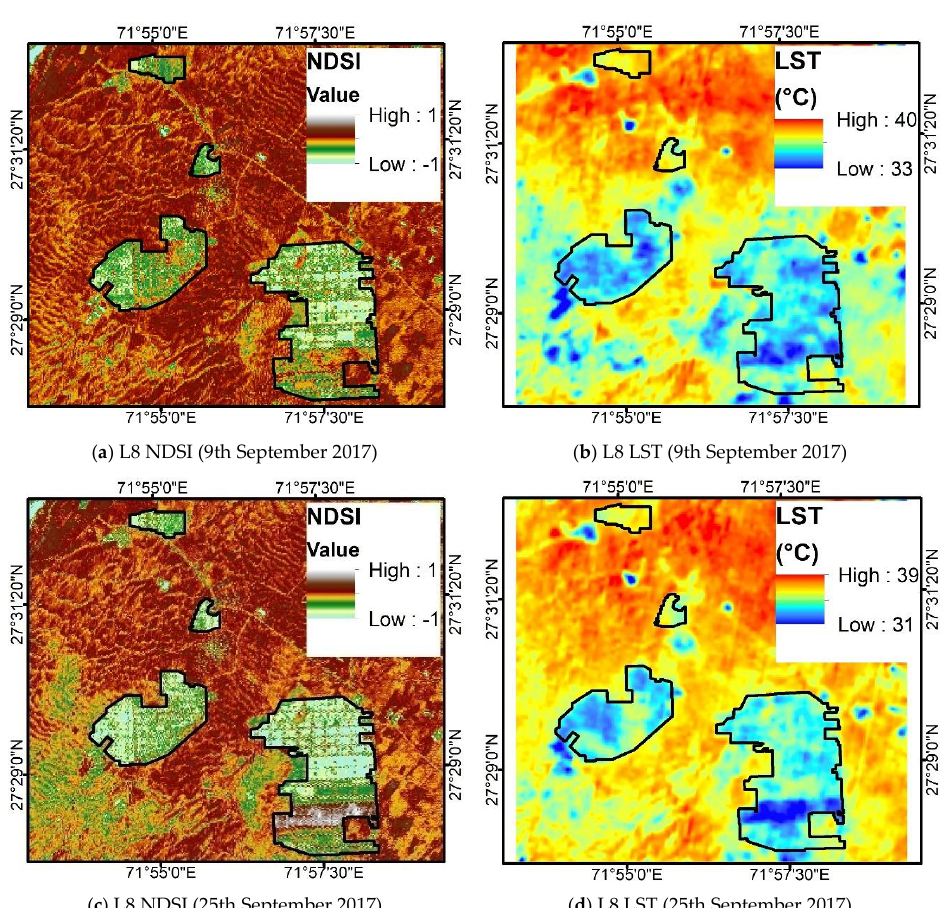
Figure 6. Visual comparison of sandy deposition on a solar farm (described within the black border). High values of normalized difference sand index (NDSI) shown in ( a ) and ( c ) within the black border indicates the location of sandy deposition. Landsat 8 generated land surface temperature (LST) pattern during the same period shows the lowest temperature (bluish tints) for the sandy deposition areas on top of the panels ( b ) and ( d ).